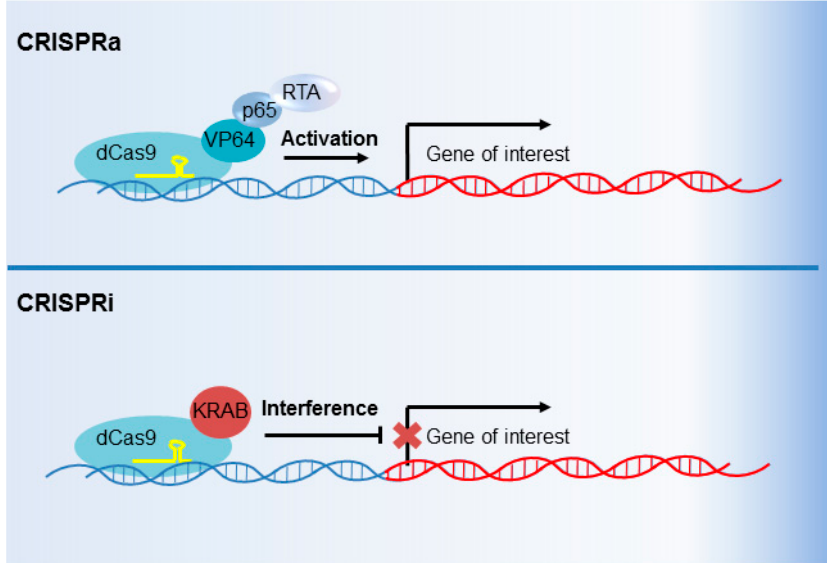
Figure 5. CRISPR activation (CRISPRa) and CRISPR interference (CRISPRi) overview. Catalytically